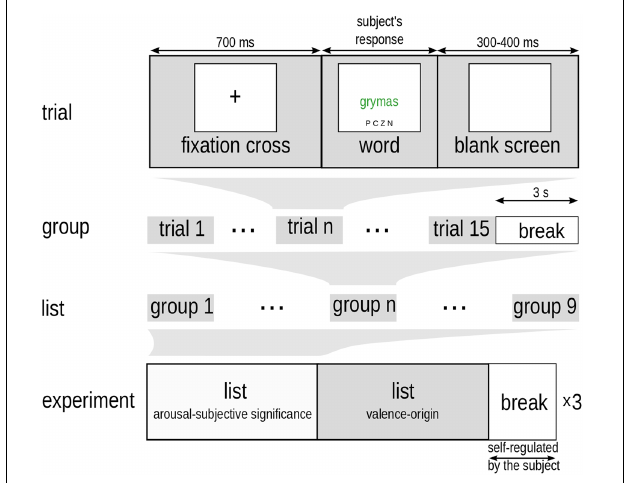
FIGURE 2 | Outline of the experimental protocol.